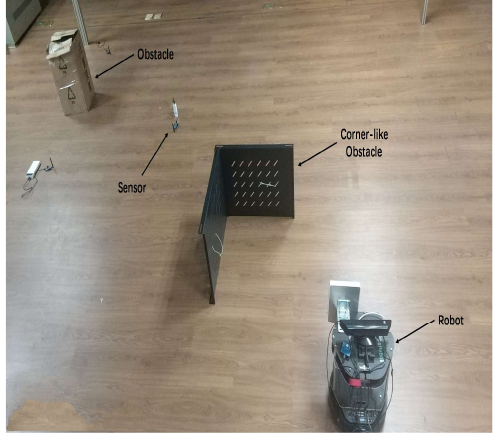
Figure 6. The experimental